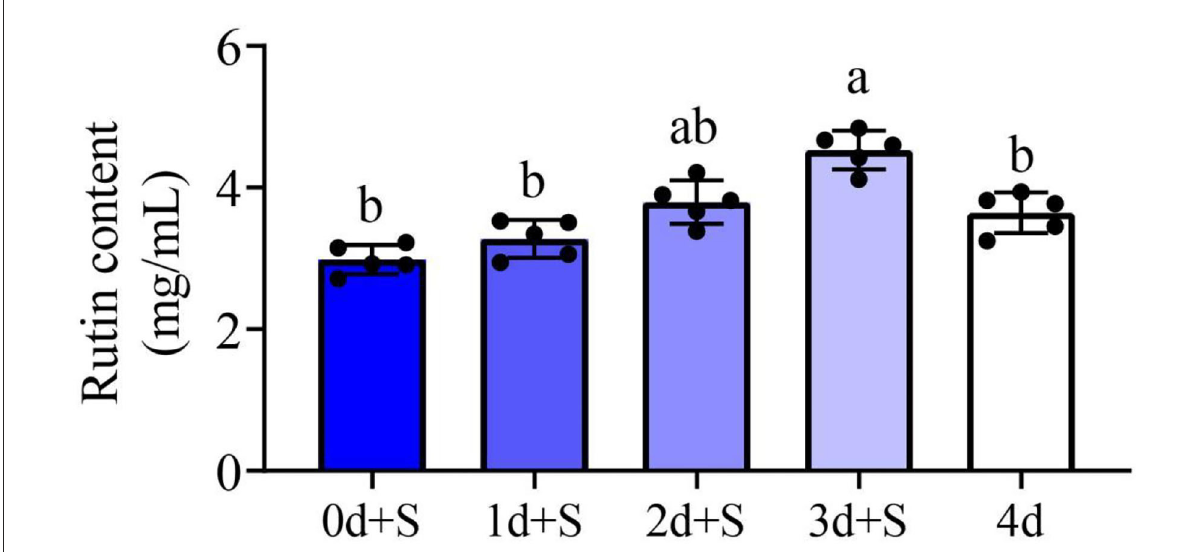
FIGURE2 The rutin content in different treatments. Different columns represent different treatments, and dark to light color represents the salt addition time from long to short. Lowercase letter(s) indicate significant differences ( α = 0.05). Each black point represents the average value of replicates.